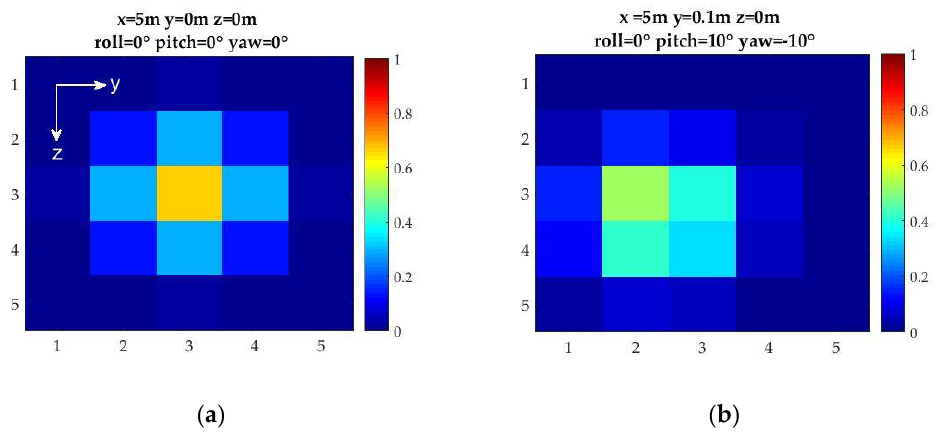
Figure 2. Sample simulator outputs for different relative geometries between the light source and the light detector array with pixel intensities normalized at maximum intensity obtained at x = 4 m: ( a ) alignment with x = 5 m offset; and ( b ) translation (along the y -axis) and rotational offset (pitch and yaw).